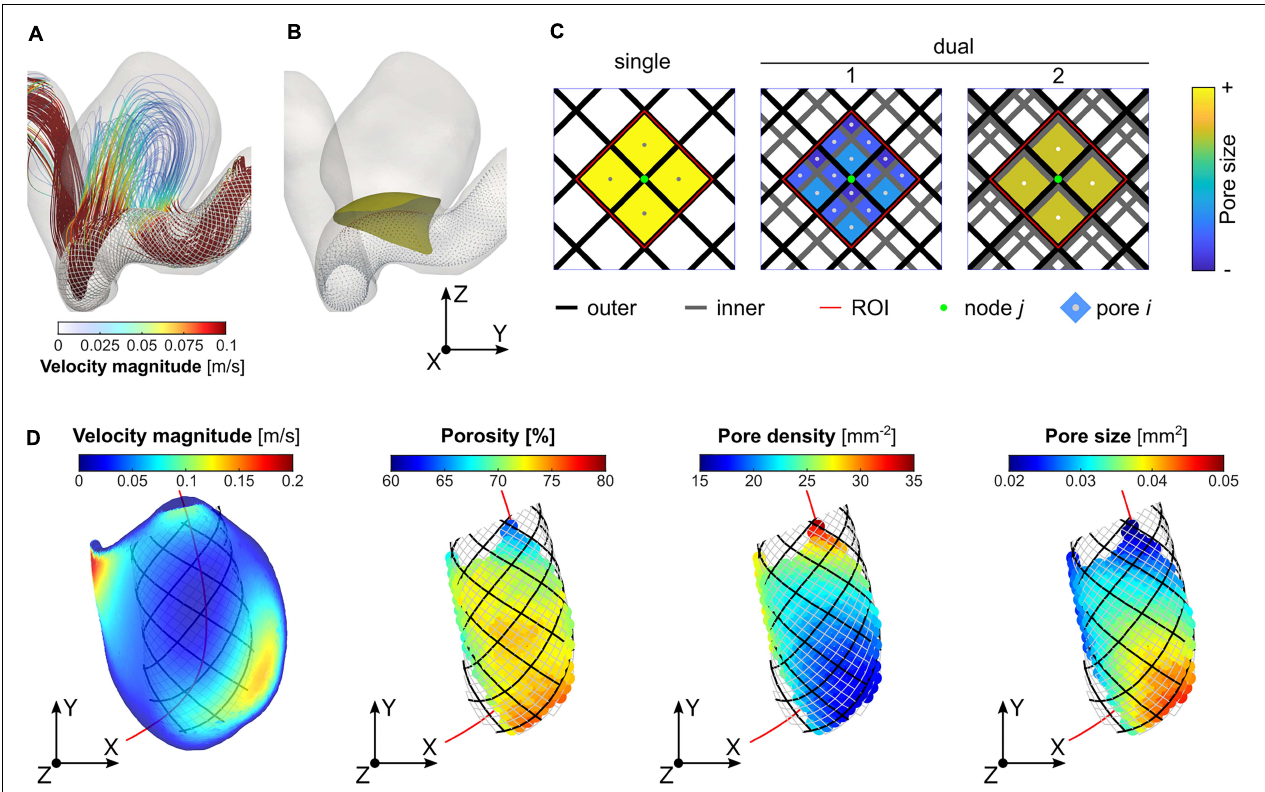
FIGURE 1 | Determination of the region of interest (ROI) and calculation of the local porosity, pore density, and pore size: (A) visualisation of streamlines (Case ID: C0016), (B) illustration of stent “nodes” (i.e., intersections of stent wires) and a neck reference surface; (C) determination of the ROI (area within the dashed red lines) corresponding to a specific “node” (the central point in green) of the outer-layer stent, and measurement of the average local pore size; and (D) visualisation of velocity distribution on the reference neck surface, and plots of the three microstructural parameters on every stent “node” within the aneurysm